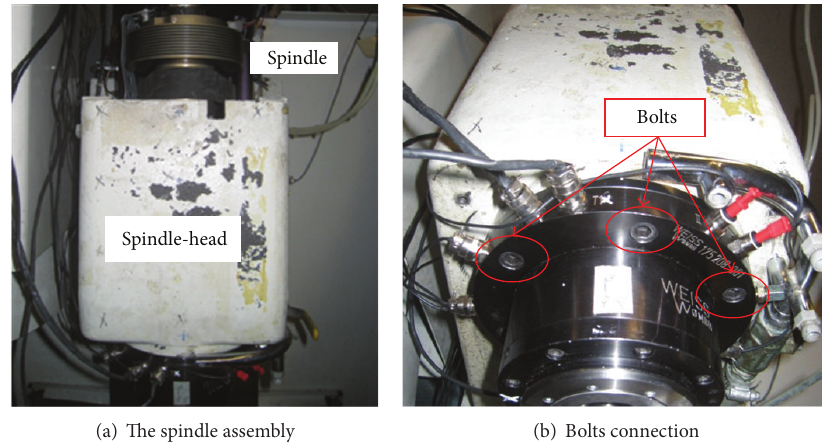
Figure 3: Coupled modeling of the machine-tool spindle